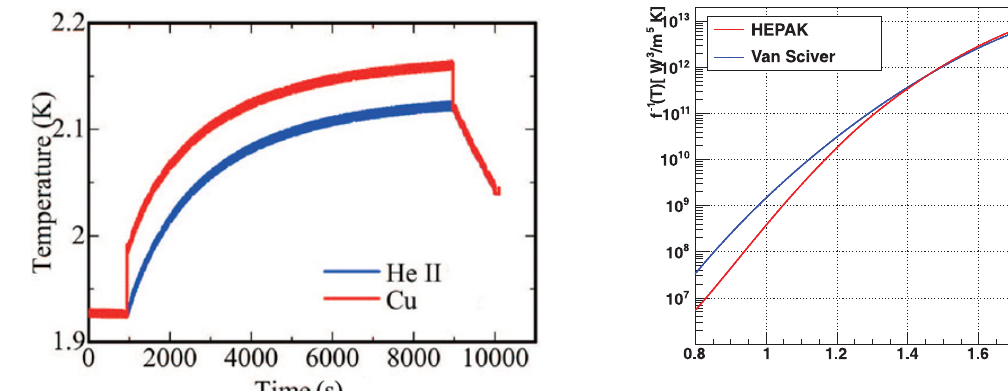
Figure 7. f ( T ) − 1 as a function of temperature. The red line is derived from HEPAK [9] and the blue line from Van Sciver [5]